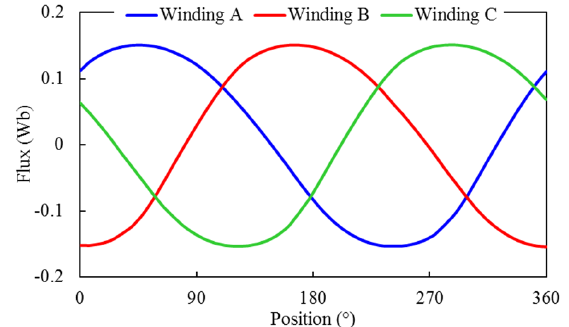
Figure 16. PM flux linkages.